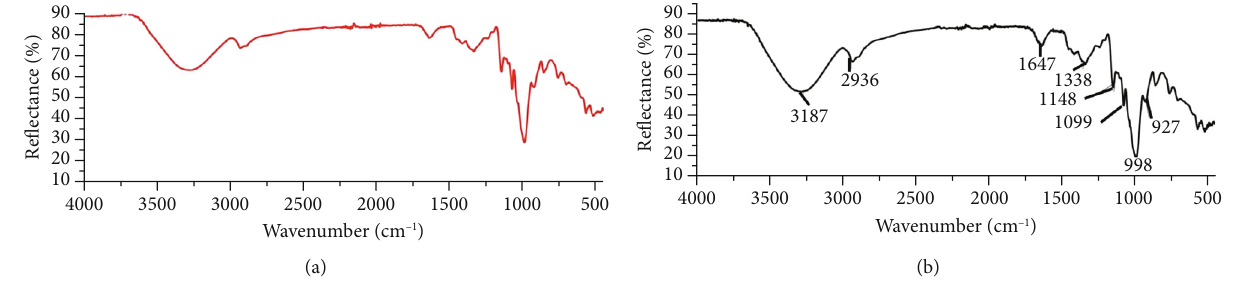
Figure 5: FTIR spectra of the (a) active fi lm and (b) PS-based fi lm.